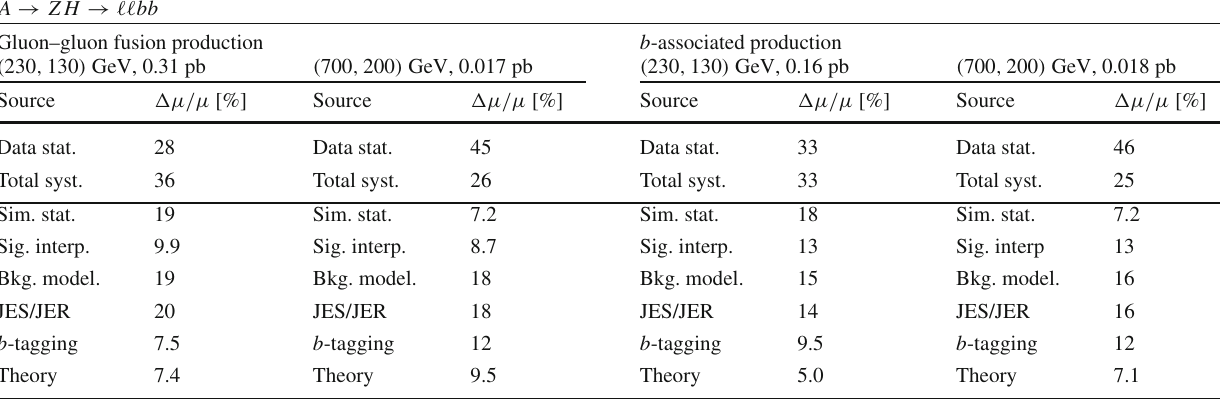
Table 3 The effect of the most important sources of uncertainty on the are shown next to the indicated mass points. JES and JER stand for jet energy scale and jet energy resolution, ‘Sim. stat.’ for simulation signal-strength parameter at two example mass points of ( m A , m H ) = ( 230 , 130 ) GeV and ( m , m ) = ( 700 , 200 ) GeV in the (cid:6)(cid:6) bb channel, statistics, ‘Sig. interp.’ for signal interpolation, and ‘Bkg. model.’ for A H the background modelling. ‘Theory’ refers to theoretical uncertainties for both gluon–gluon fusion and b -associated production of a narrow- in the signal samples due to the PDF choice, factorisation and renor- width A boson. The signal cross sections are taken to be the expected malisation scales, and initial- and final-state radiation median upper limits (see Sect. 8) and they correspond to values that